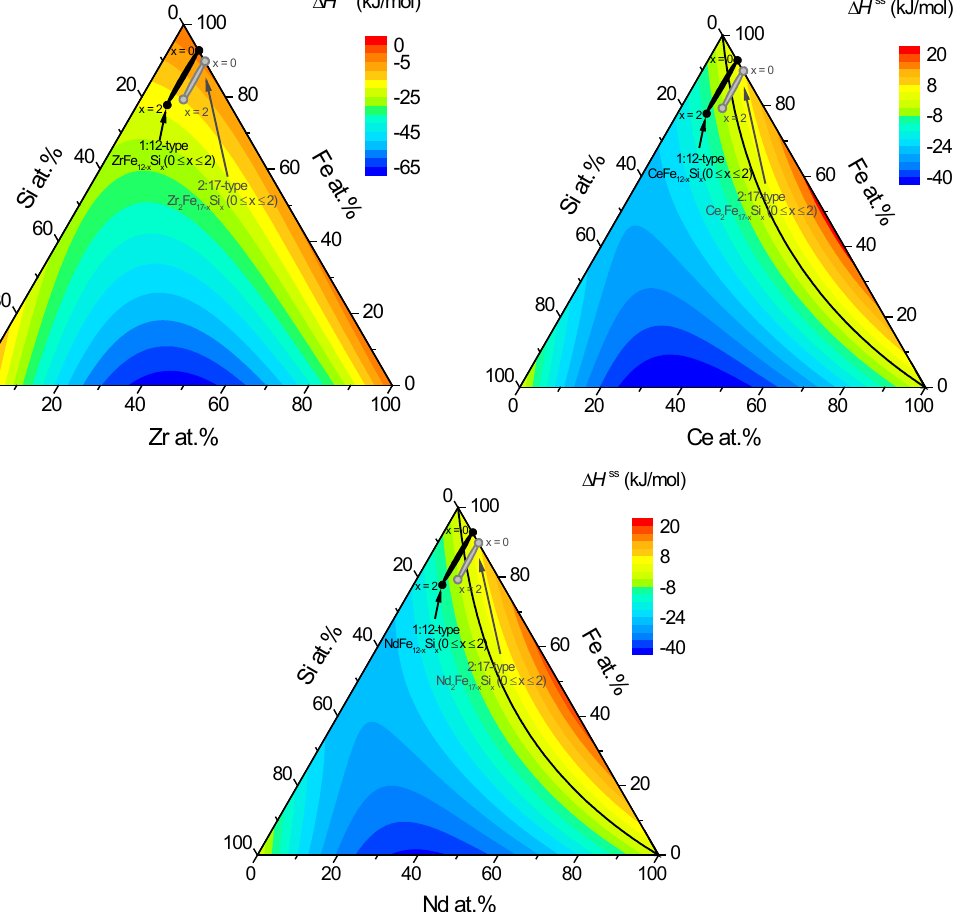
Figure 2. Compositional dependences of the formation enthalpies of the solid solution ∆ H ss of ternary (Zr, Ce, and Nd)-Fe-Si systems. Key composition regions are marked in grey (2:17-type phases) and black (1:12-type phases). Black solid lines are ∆ H = 0